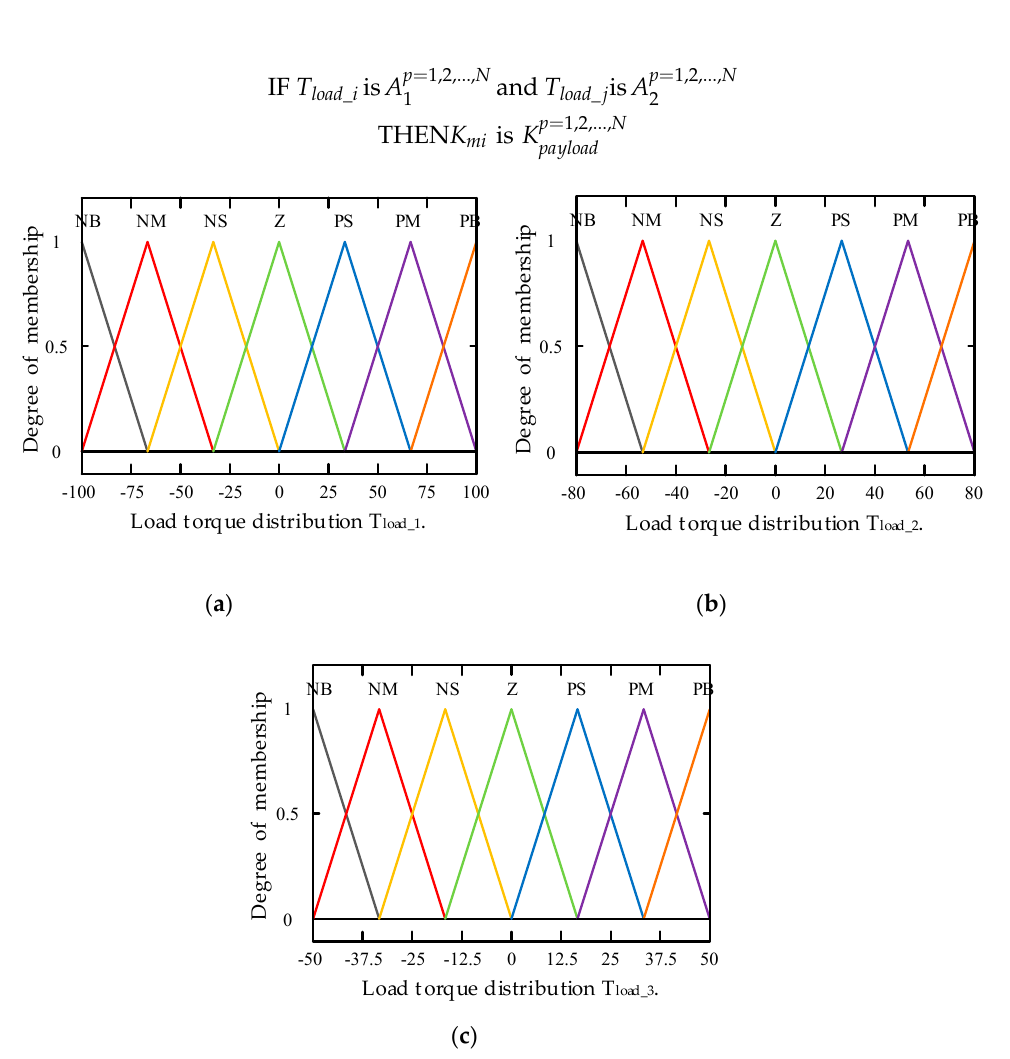
Figure 7. Membership function of the load torque variation: ( a ) T load_ 1 , ( b ) T load_ 2 , ( c ) T load_ 3 . Table 2. Rules table of the fuzzy logic 01 0.5